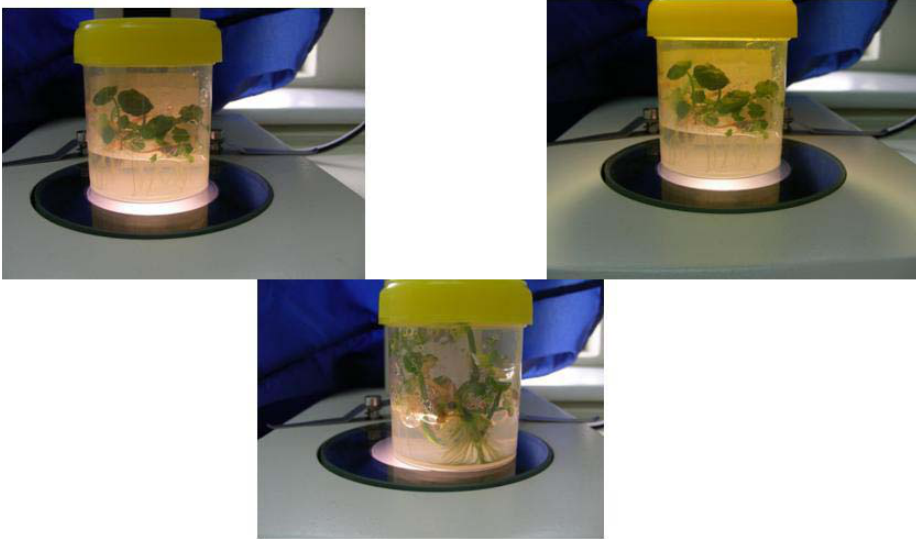
Figure 7. Rooting of C.asiatica shoots in full-strength MS medium supplemented with IBA 0.5 mg/L after 3